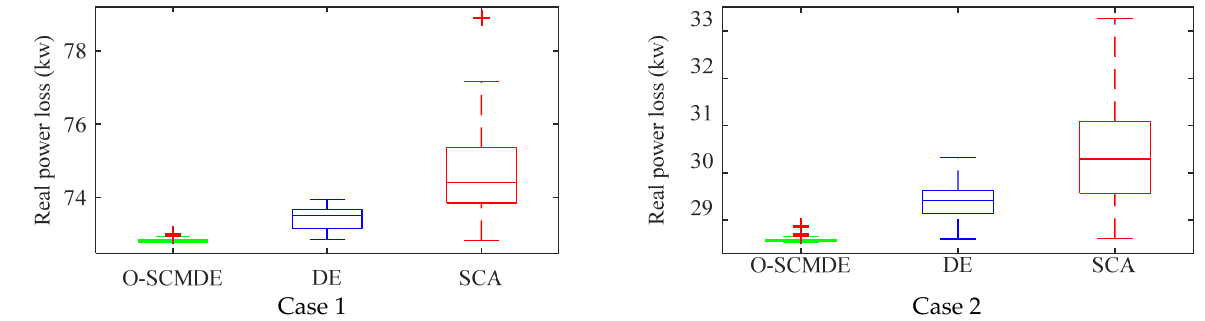
Figure 20. Box plot for scenario I of the 33 bus test system.